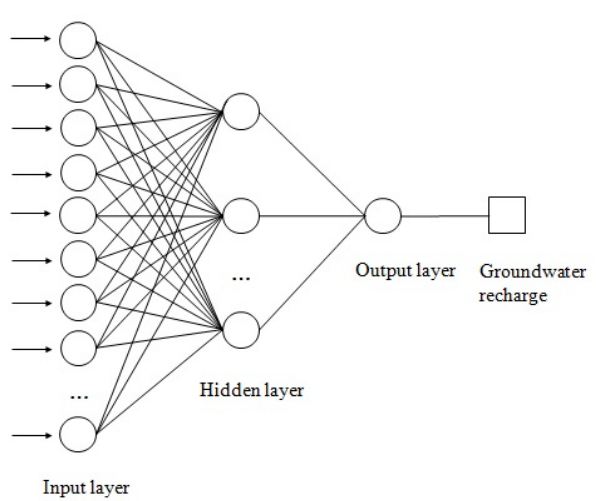
Figure 2. Structure of MLP network for predicting groundwater recharge.